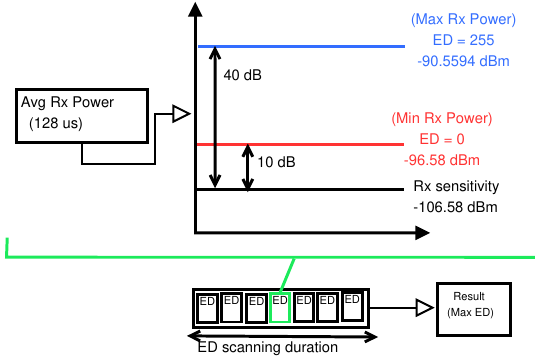
Figure 5. Ns-3 energy scanning and ED procedures.